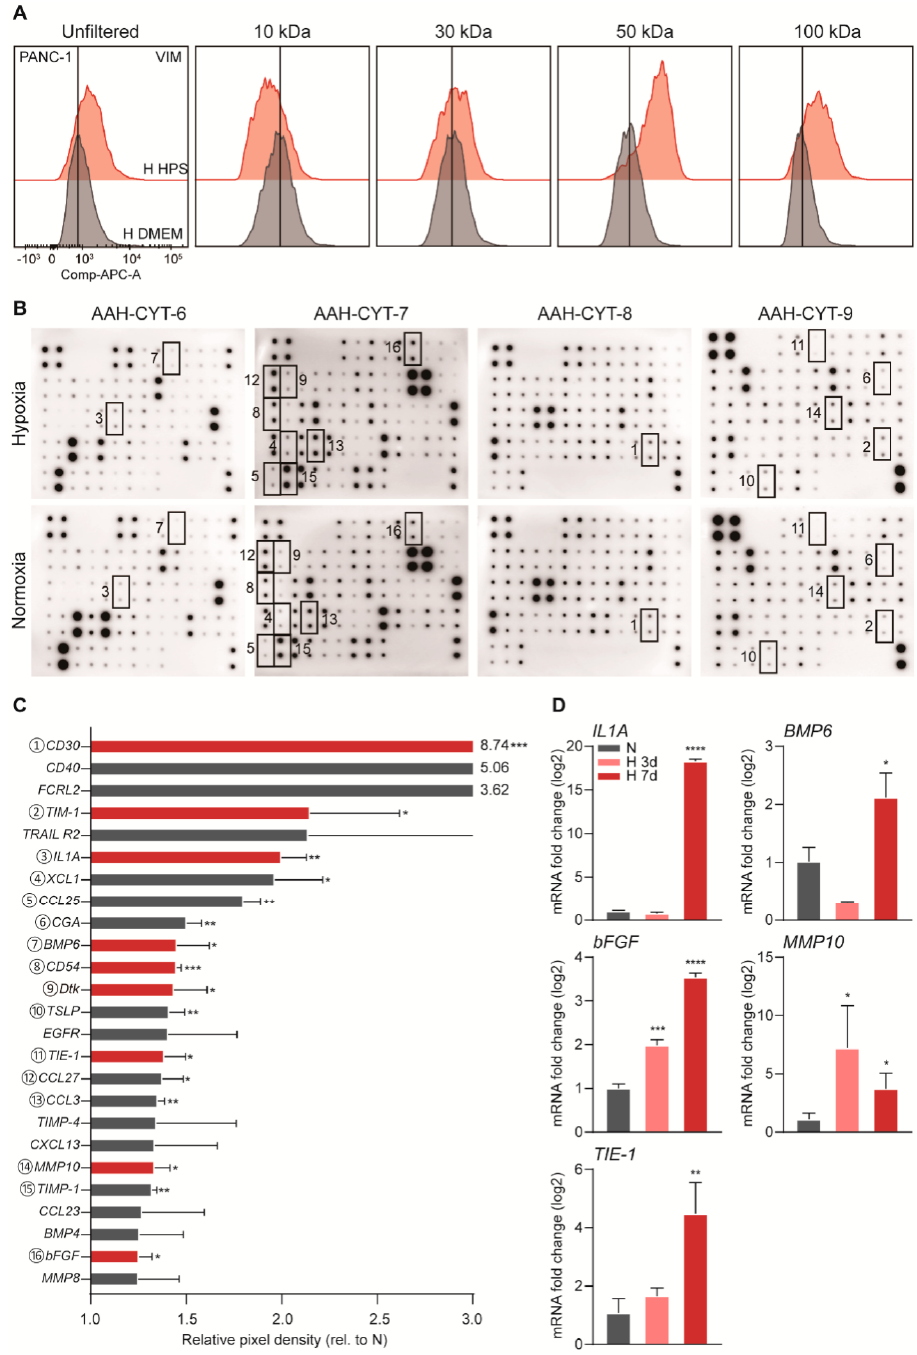
Figure 4. Candidate stromal cytokines upregulated in response to hypoxia. ( A ) PANC-1 cells were exposed to 3 days of unfiltered, 10, 30, 50, 100 kDa filtered HPS (upper row peaks) or unconditioned medium (lower row peaks). Flow cytometry was performed for VIM. ( B ) An AAH-CYT-4000 (RayBiotech, Norcross, GA, USA) cytokine array of four membranes was used to analyze HPS, with NPS as control. Pixel density was determined by measuring spot chemiluminescent signals in ImageJ, and calculated after correction for the negative and positive controls on the membranes and dividing by the NPS control. Coded boxes on membranes scans correspond to matching significantly upregulated cytokines listed in descending order in panel C. ( C ) All highly induced cytokines are plotted. Statistically significant upregulated cytokines within the size range determined (between 30–100 kD) are